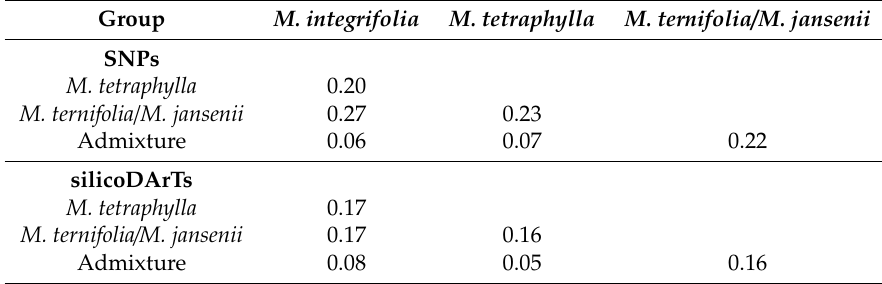
Table 2. Pairwise population matrix of Nei’s genetic distance (D) among the clusters of Macadamia wild germplasm, using SNP and silicoDArT markers.